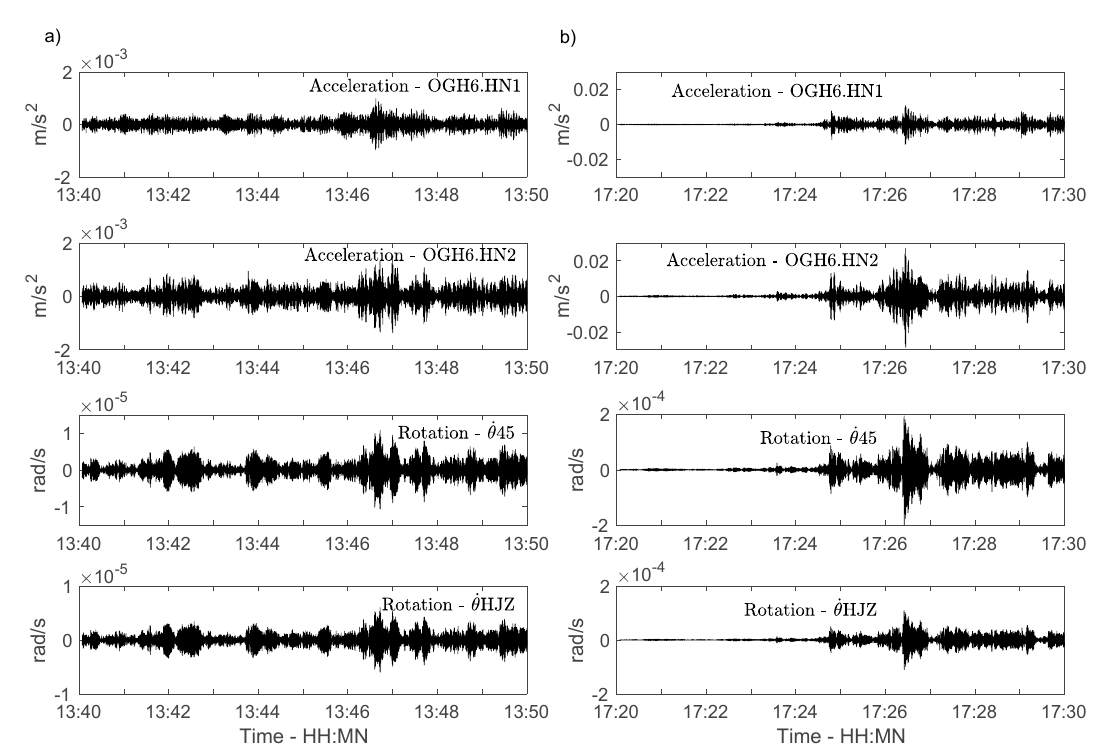
Figure 4. Example of 10 min recordings in translation and in rotation, ( a ) under ambient vibrations, ( b ) at the time of the local storm. Note the amplitude difference on the y axes.